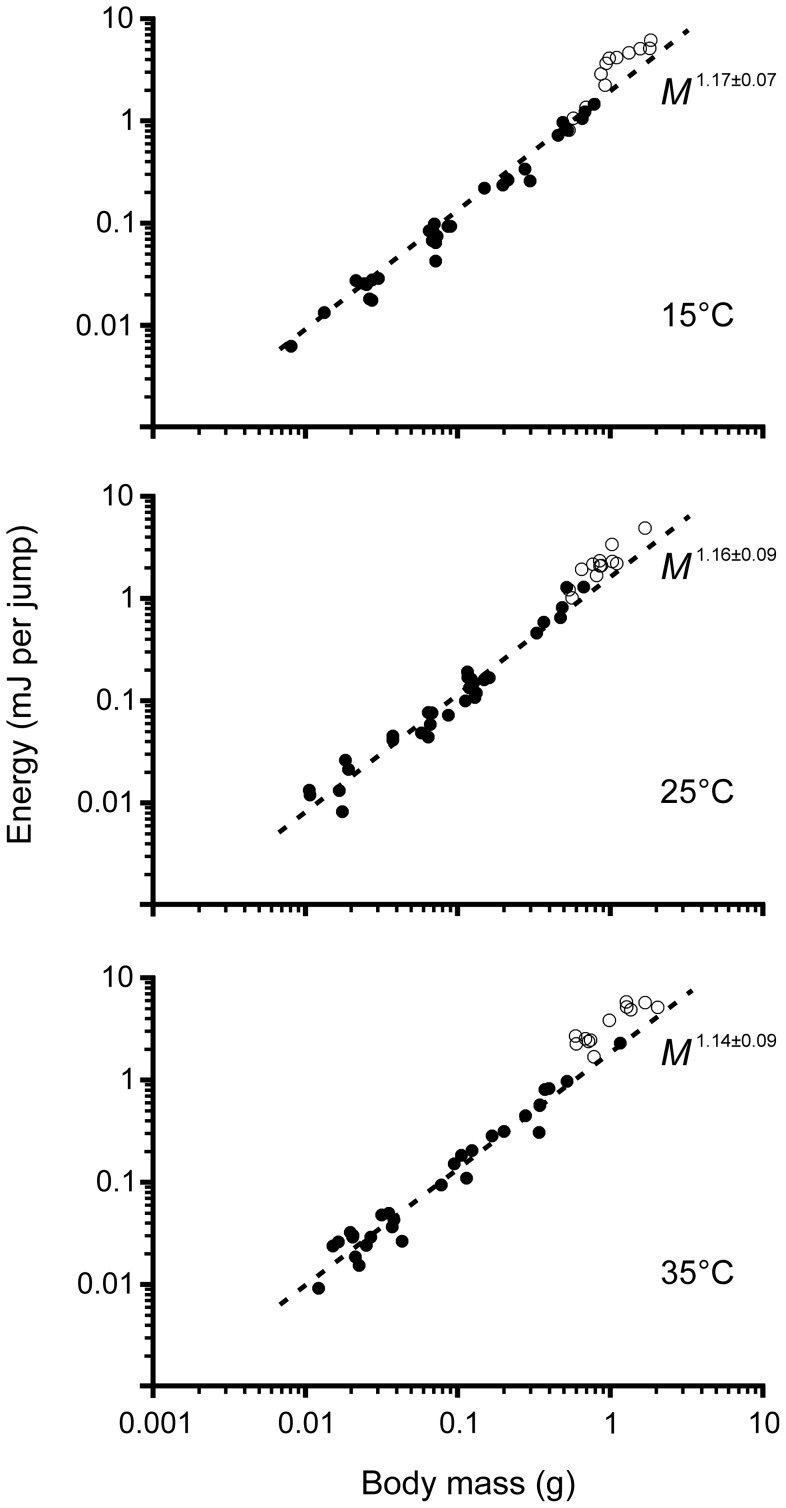
Effect of temperature on the allometric relationship between jump energy and body mass across the five juvenile life stages of Locusta migratoria (filled circles; N = 30 juvenile individuals per temperature, N = 90 juvenile individuals in total).Adult jump energy is also presented (unfilled circles; N = 12 adult individuals per temperature, N = 36 adult individuals in total), but is not included in the regression due to their disproportionately high values.